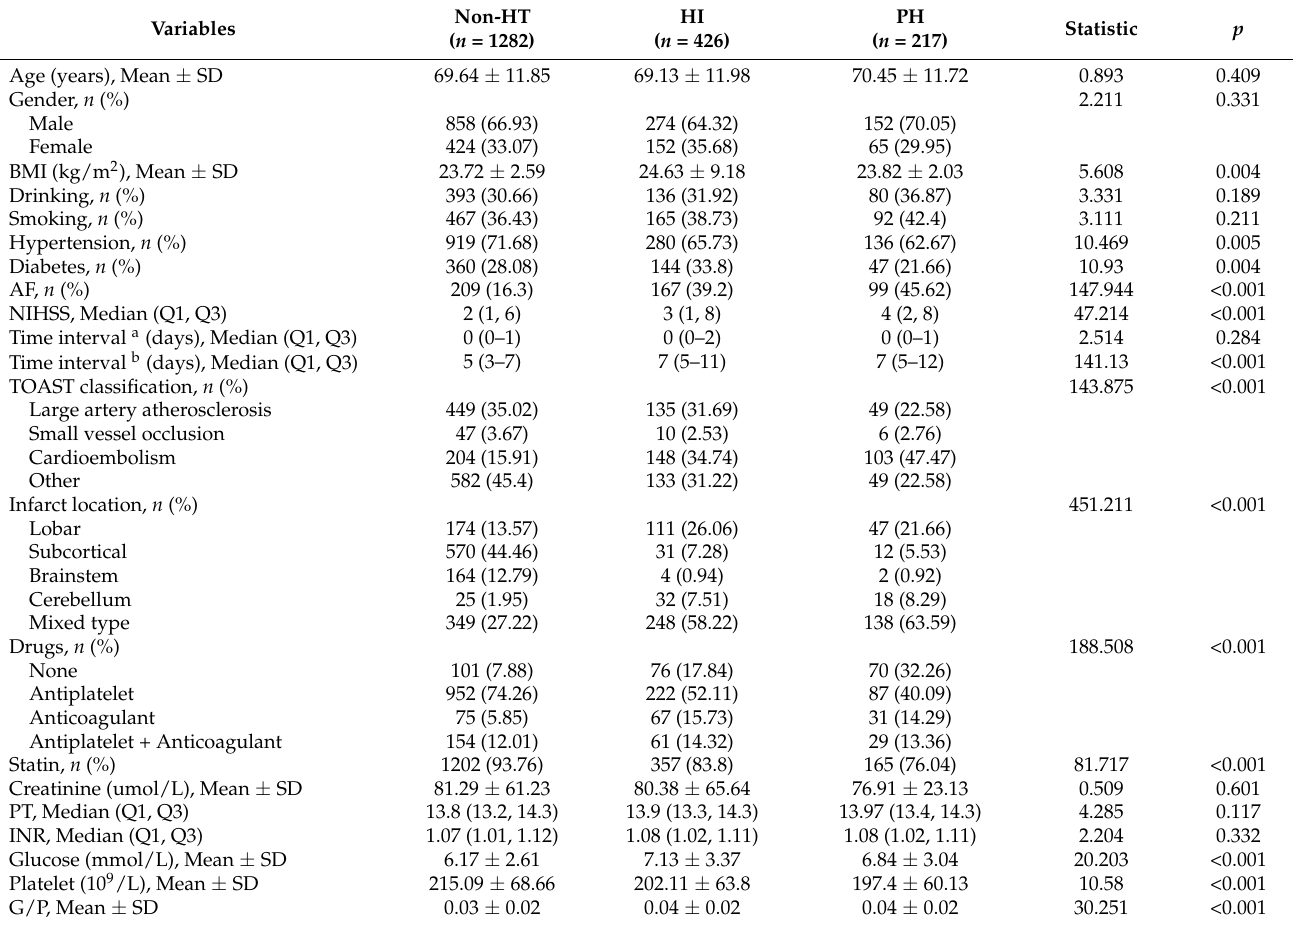
Table 2. Characteristics of patients with HI or with PH.